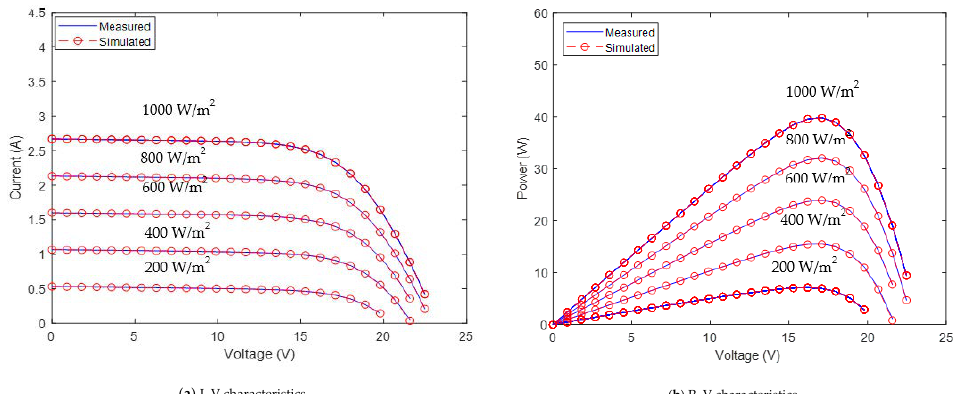
Figure 25. Depiction of the measured and simulated data obtained by MJSO on ST40 under different G with T = 25 °C.